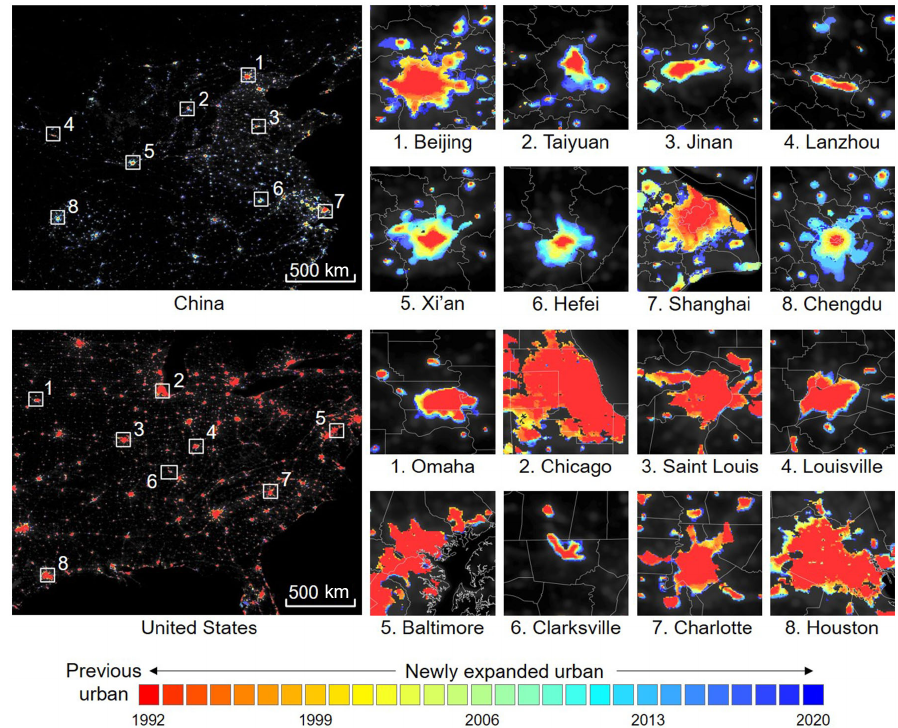
Figure 13. Dynamics of urban extents from 1992 to 2020 in different cities of China and the United States. The spatial range of each subset is 100km × 100km.